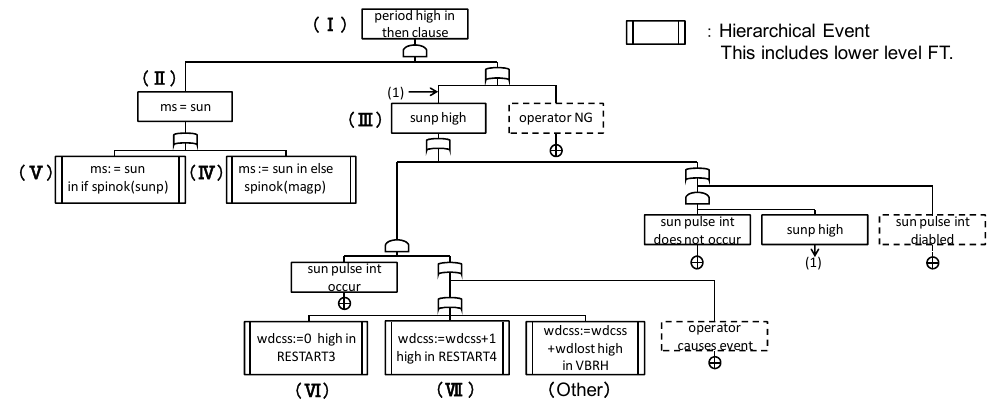
Figure 19. Top-level FT shown in hierarchical format.